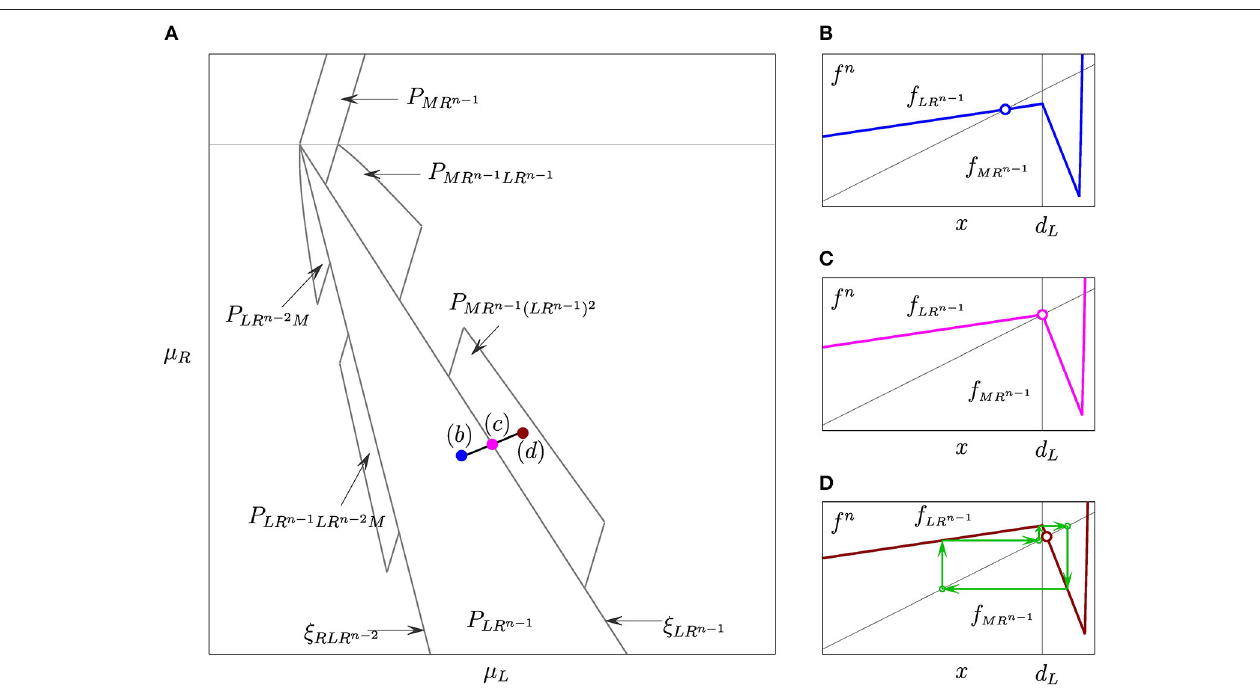
FIGURE 5 | (A) The left and the right 1 · n -, 2 · n -, and 3 · n -fins of the PA-region P LR n − 1 shown schematically in the ( µ L , µ R )-parameter plane. (B–D) Plots of f n at the corresponding parameter points marked in (A) .